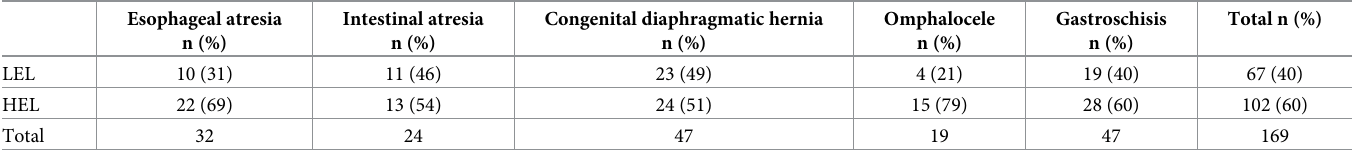
LEL corresponds to a low maternal SES; HEL corresponds to a high maternal